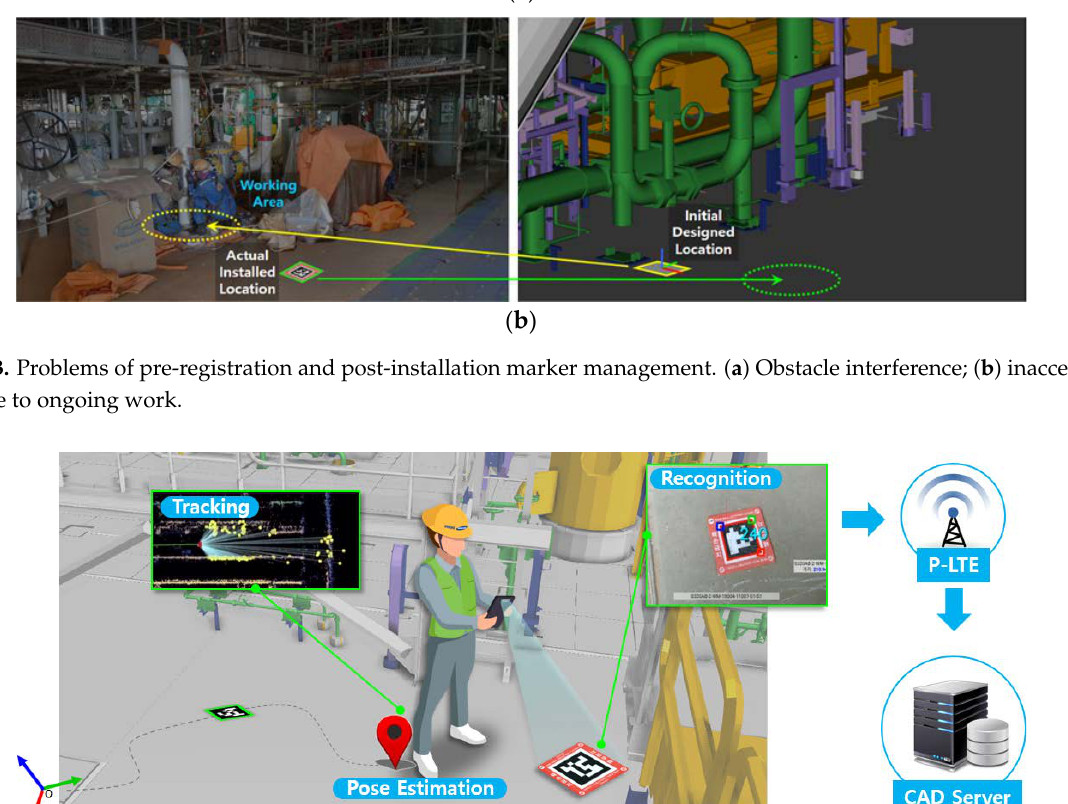
Figure 3. Problems of pre-registration and post-installation marker management. ( a ) Obstacle interference; ( b ) inaccessible area due to ongoing work.